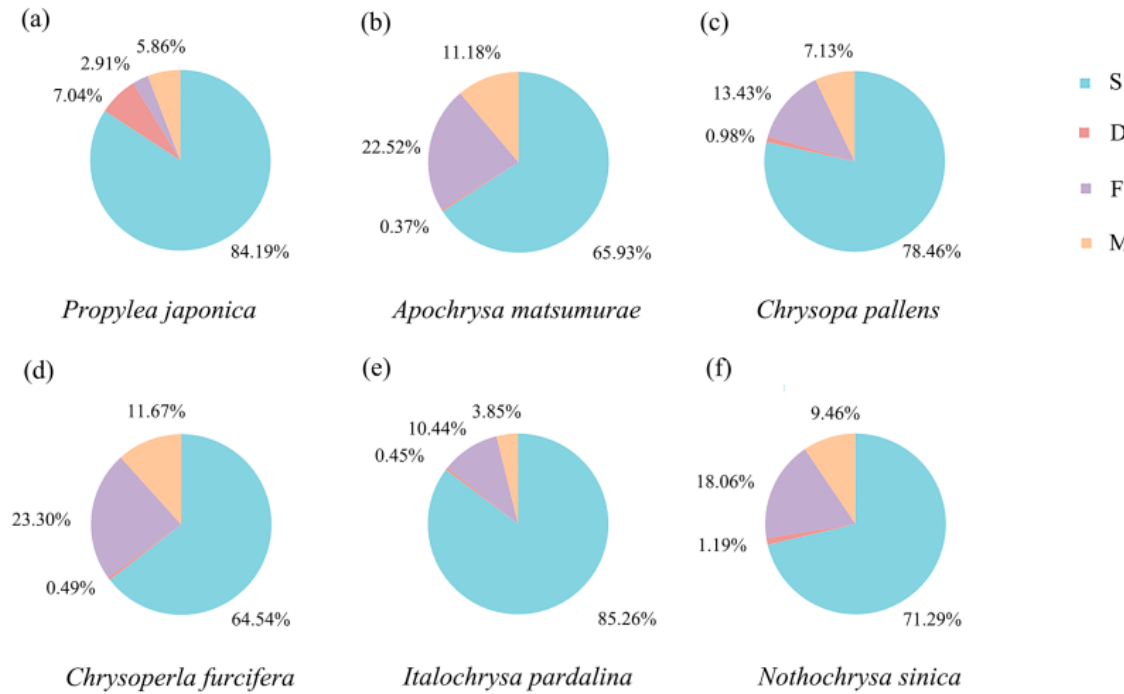
Figure 2. Summarized benchmarking of BUSCO notations for species used in this study. S: complete and single-copy BUSCOs; D: complete and duplicated BUSCOs; F: fragmented BUSCOs; M: missing BUSCOs. The different colors represent the different kind of BUSCOs, accordingly. The numbers indicate the percentage of different kinds of BUSCOs within the total number BUSCO groups searched.